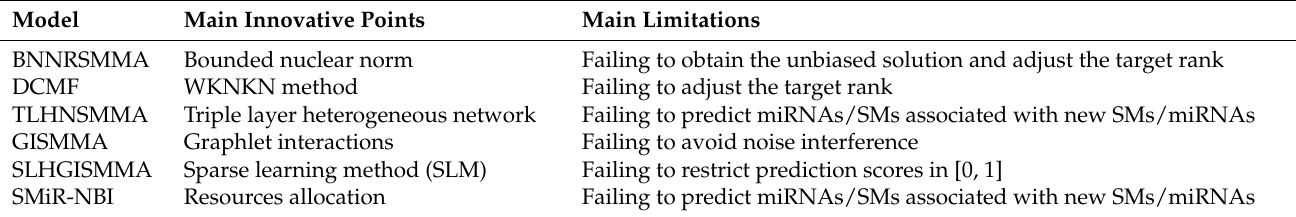
Table 1. The main innovative points and limitations of the proposed